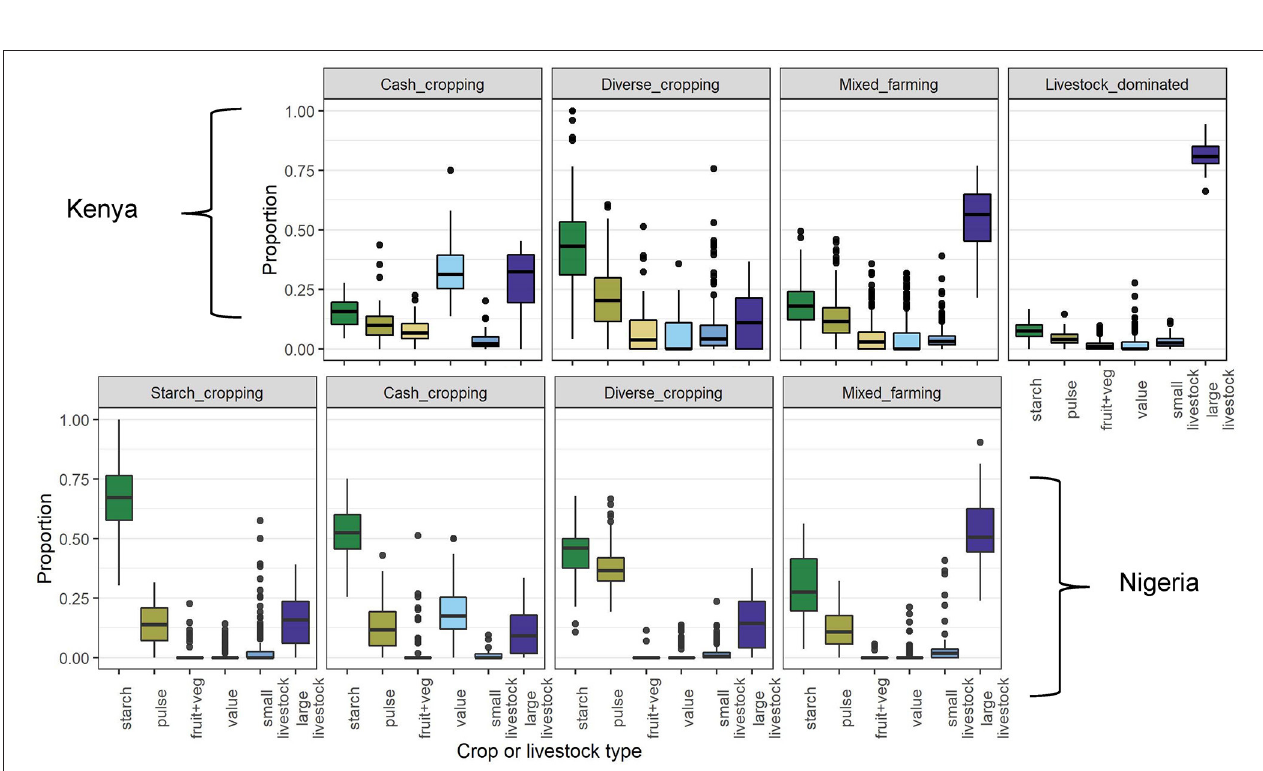
FIGURE 5 | Crop and livestock compositions of each FC group identified in the hierarchical cluster analysis. The y axis shows the weighted proportion of each crop and livestock type, the variables that were used in the cluster analysis, defined such that two TLUs are equivalent to one hectare of cropped land (see Section Methods ). Thick bars indicate medians, boxes show interquartile ranges, whiskers show points up to 1.5 times the interquartile range (above and below the quartiles) and points indicate individual observations outside of this range.